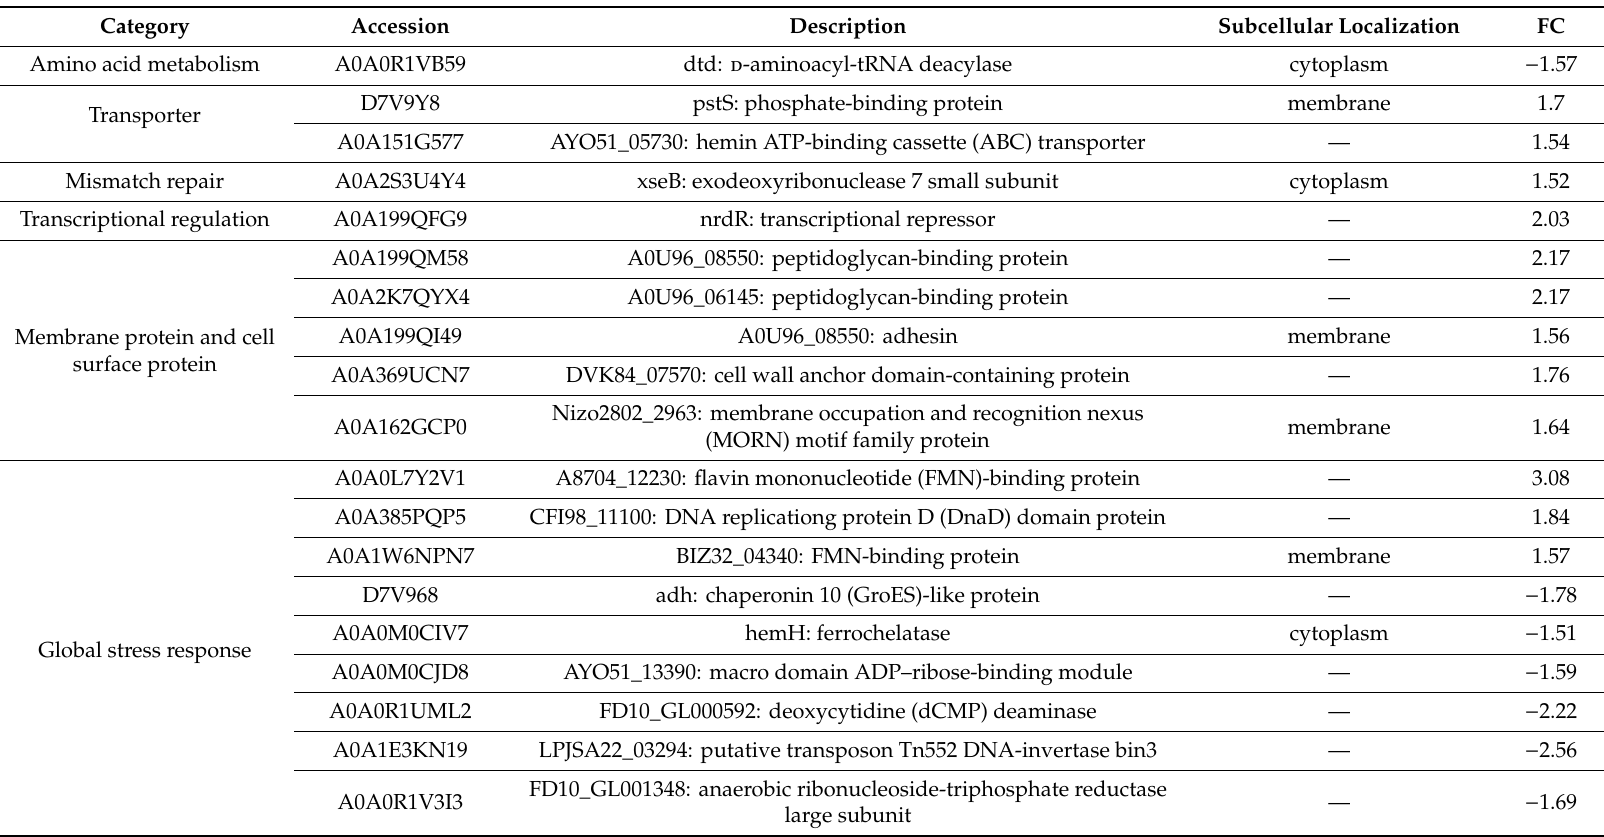
Table 2. Di ff erentially expressed proteins between L. plantarum YW11 in Pb conditions and L. plantarum YW11 in Pb-free conditions.